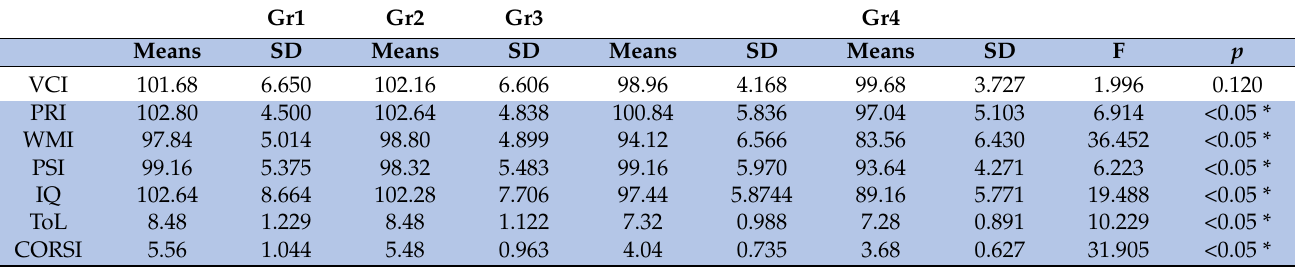
Table 1. Comparison of indices between Gr1, Gr2, Gr3 and Gr4.